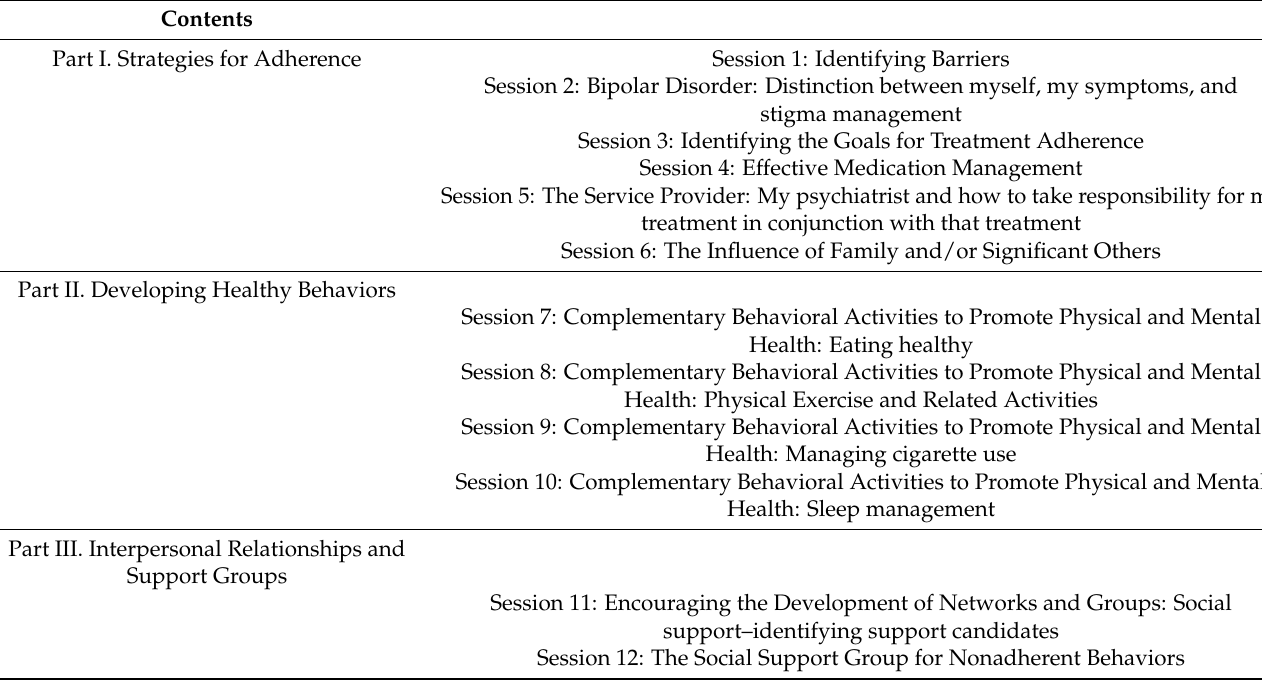
Table 1. Psychosocial Intervention